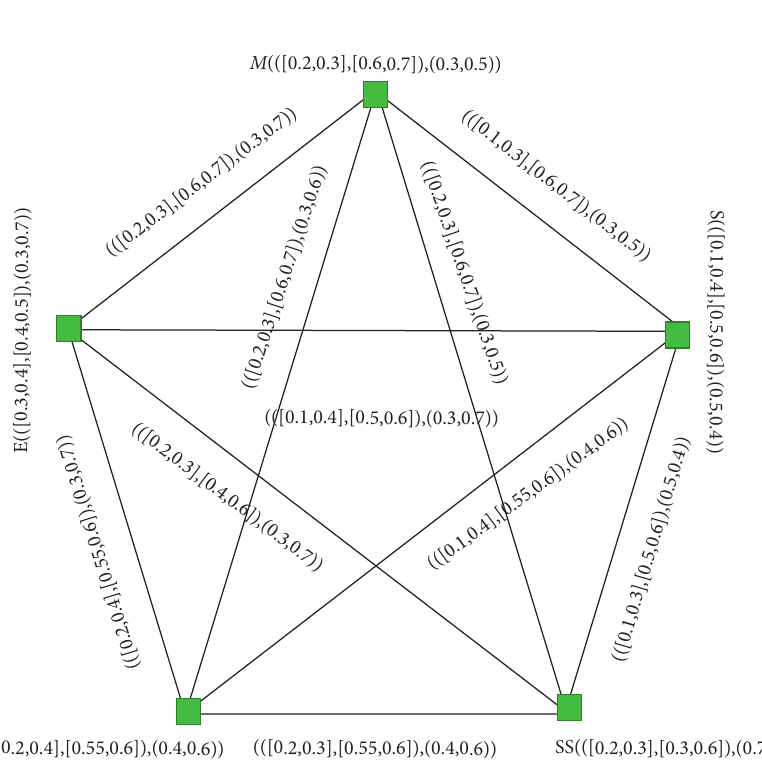
Figure 19: Cubic intuitionistic fuzzy